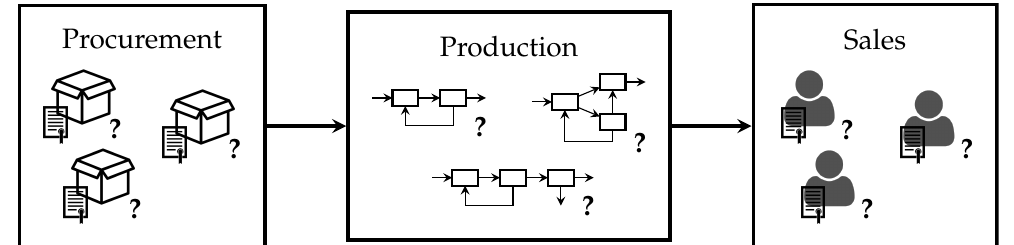
Figure 2. Simplified process diagram for the illustrative example. Three sections exist: procurement, production, and sales. In each section, decisions must be made in both discrete and continuous variable domains.